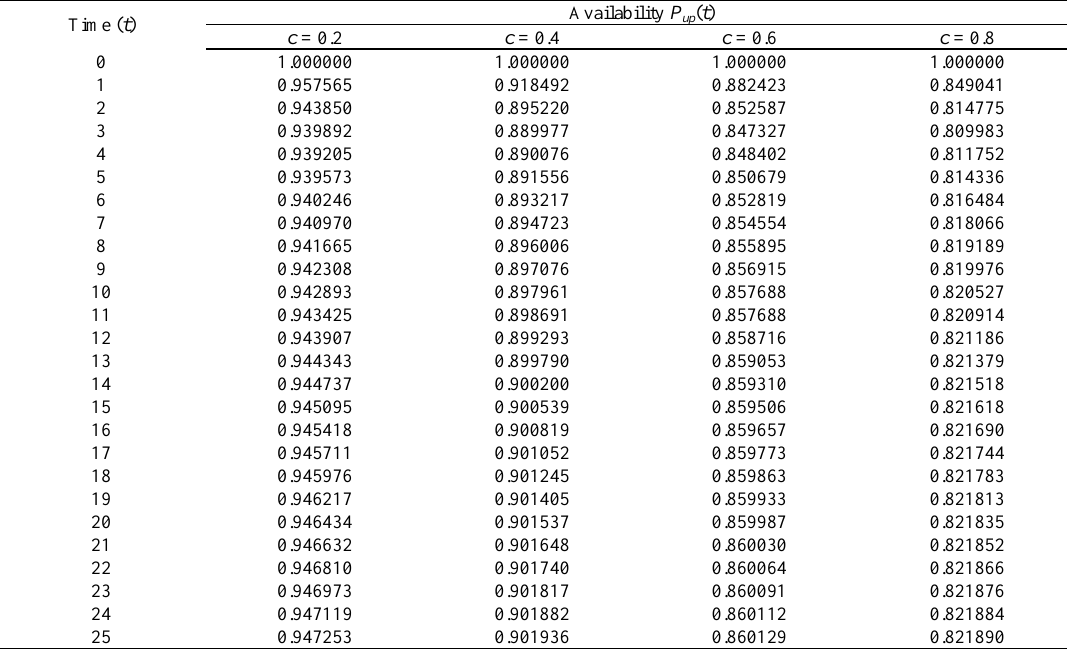
Table 4 . Availability of the system at a different value of coverage